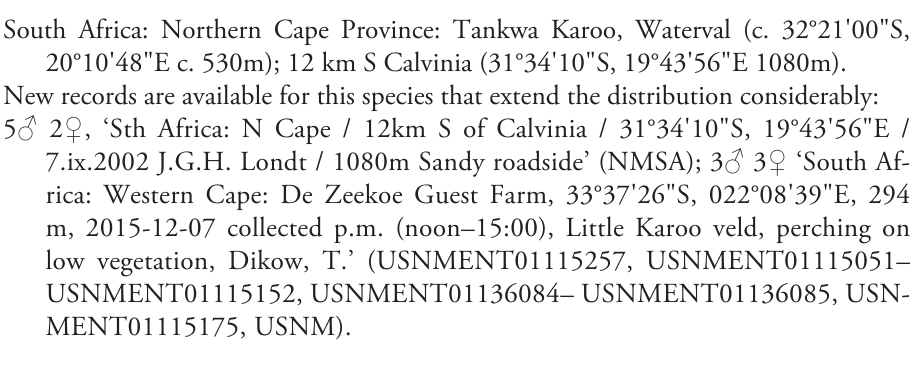
South Africa: Northern Cape Province: Tankwa Karoo, Waterval (c. 32°21'00"S, 20°10'48"E c. 530m); 12 km S Calvinia (31°34'10"S, 19°43'56"E 1080m).